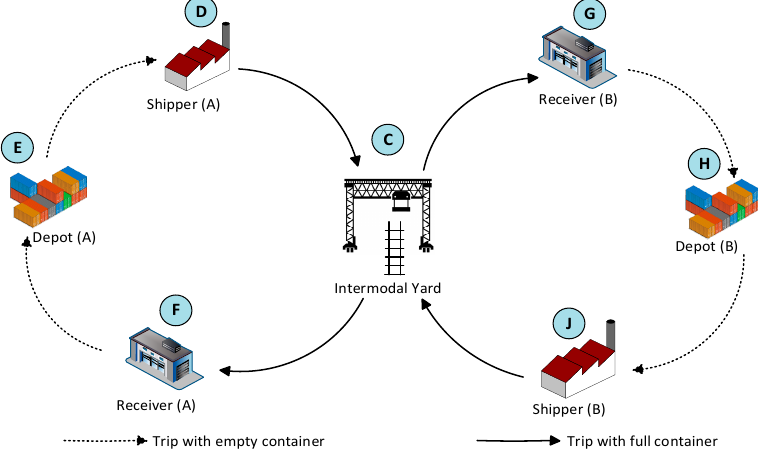
Figure 1. Intermodal freight transportation without collaboration.